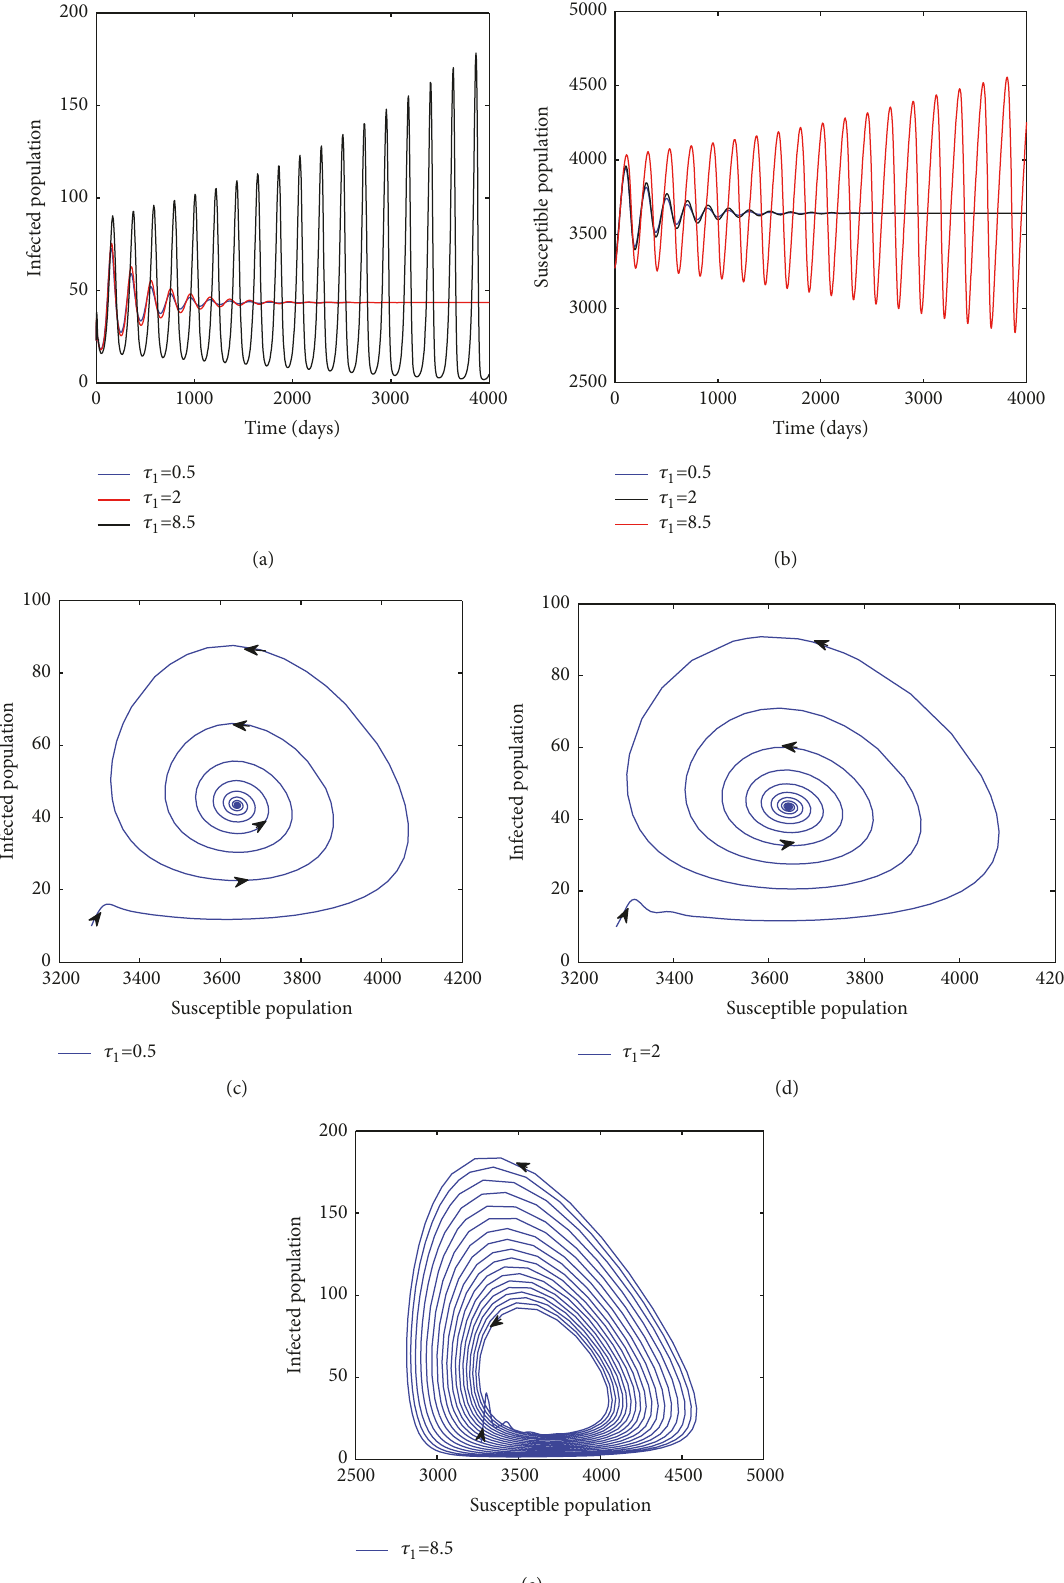
Figure 7: The effect of varying time delay 𝜏 1 on the dynamics of model (1). The delay 𝜏 1 was chosen as 𝜏 1 = 0.5,2, 8.5 . All the parameter values are the same as in Table